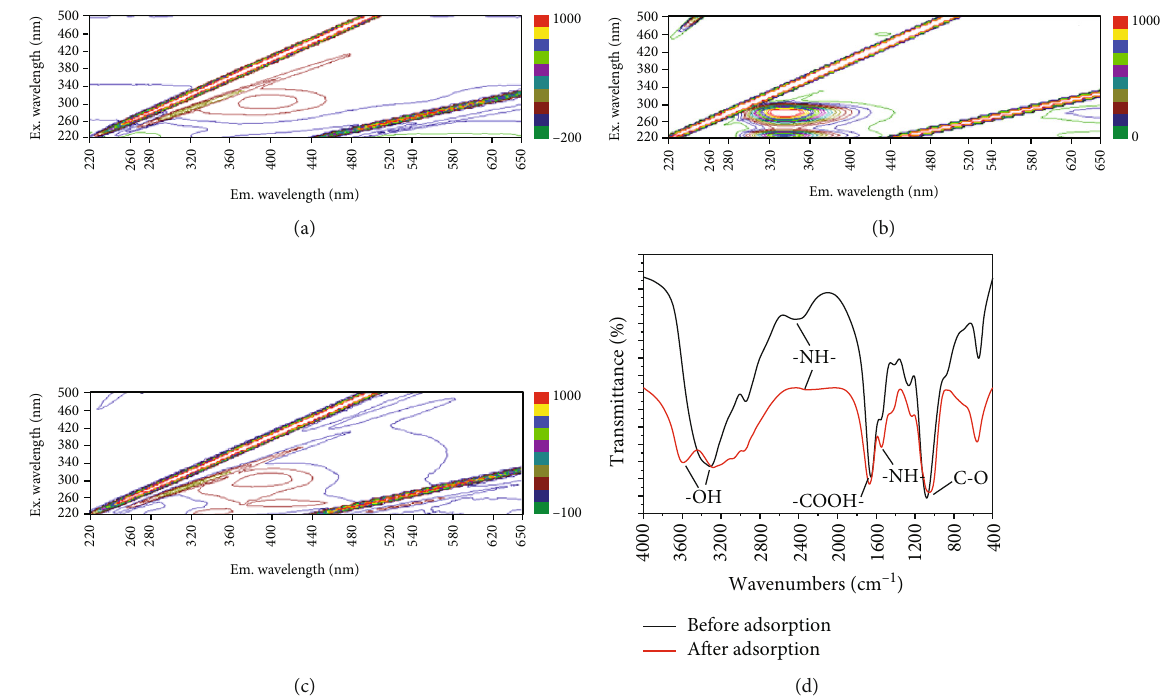
Figure 5: EEM of component of MFX adsorbing carbamazepine: (a) carbamazepine aqueous solution, (b) precipitation after adsorption, (c) liquid supernatant after adsorption, and (d) FTIR of MFX before and after